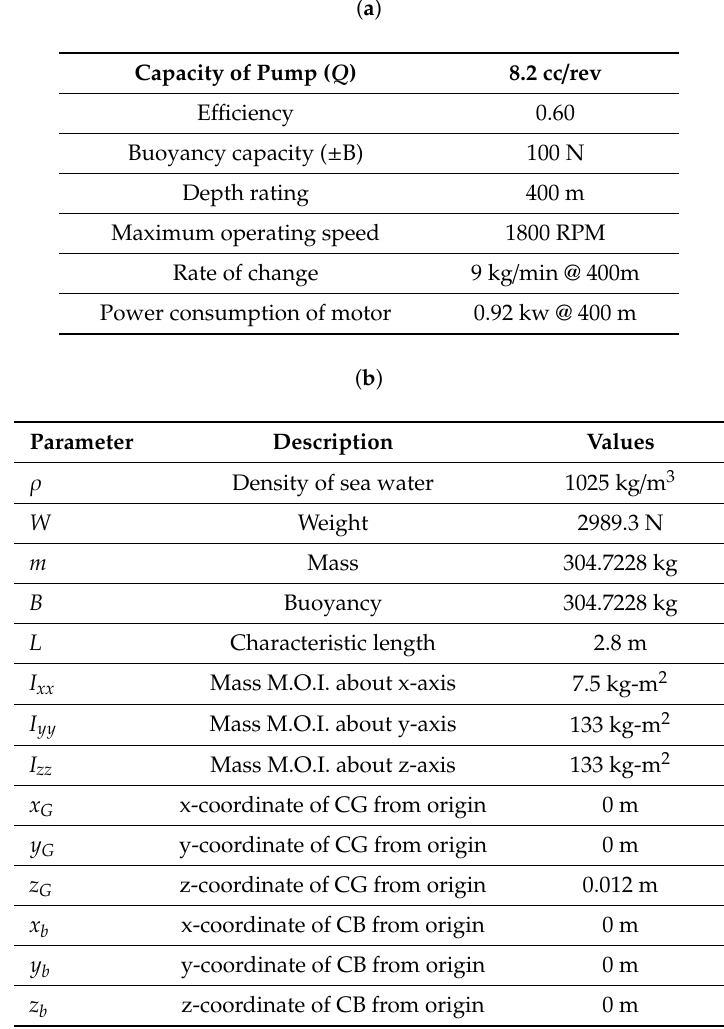
Table 4. ( a ) Technical Specifications of VBS ( b ) Input and Output Design Parameters of CSM for the Design of